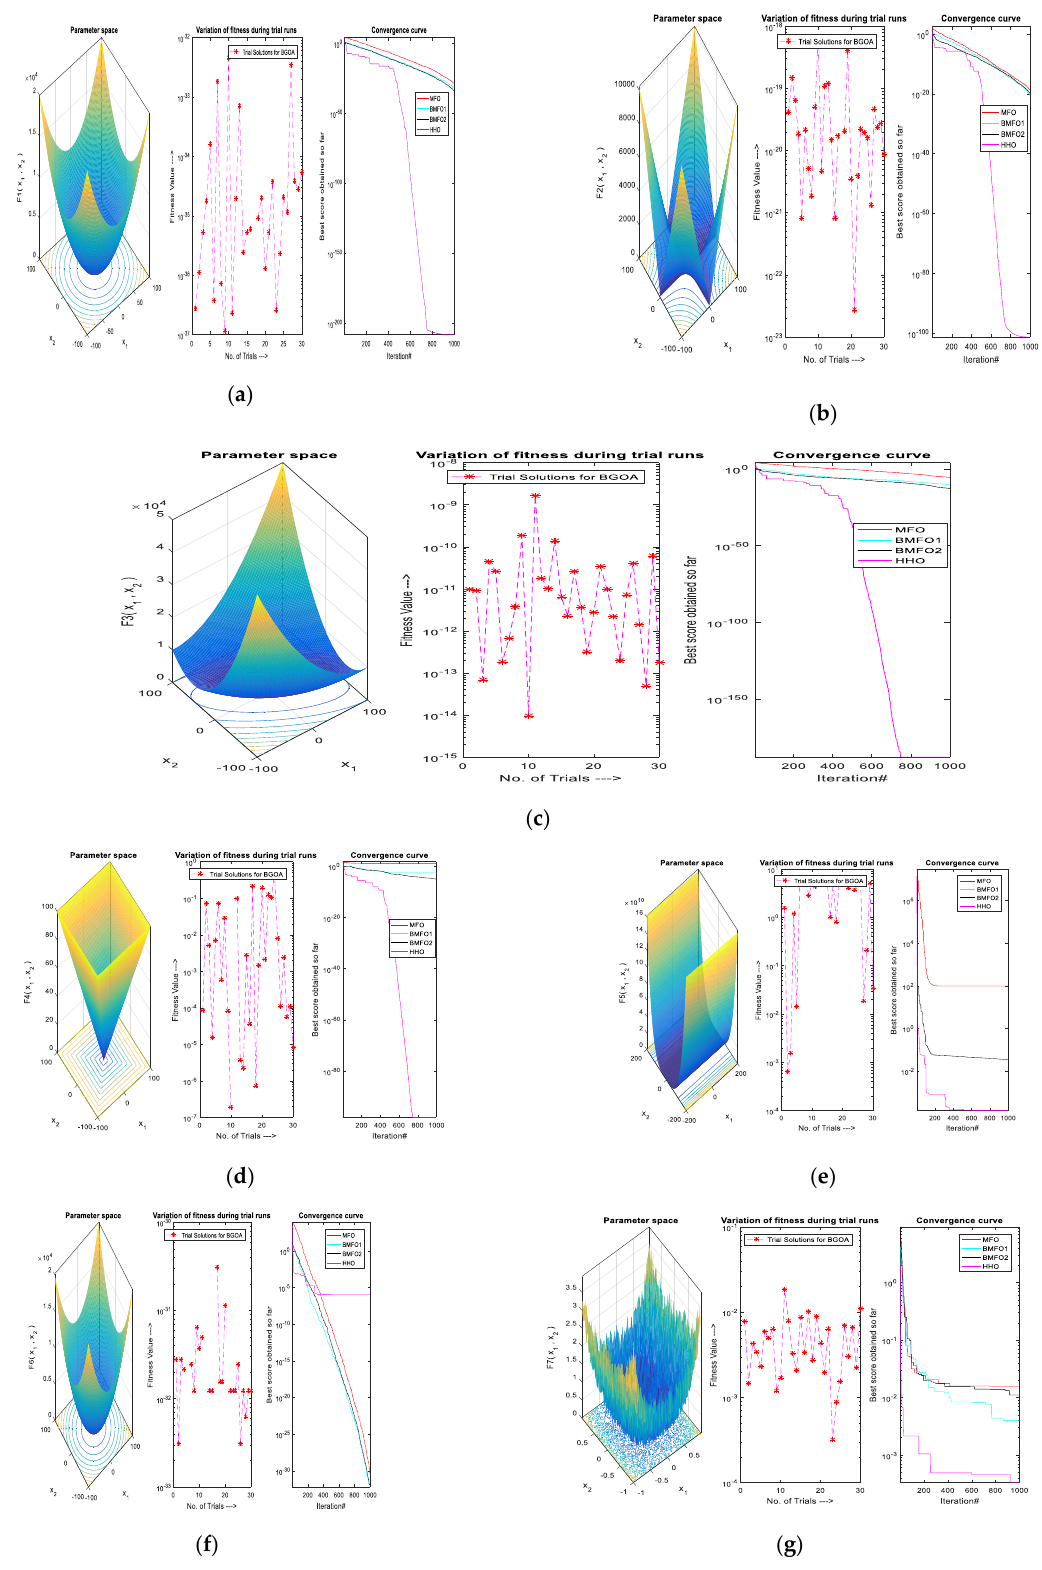
Figure 5. ( a – g ) Convergence curve of all algorithms for unimodal benchmark functions. The convergence curve and trial solutions for BMFO1, BMFO2, and HHO for f1 to f7 unimodal benchmark functions are presented in Figure 5a – g.